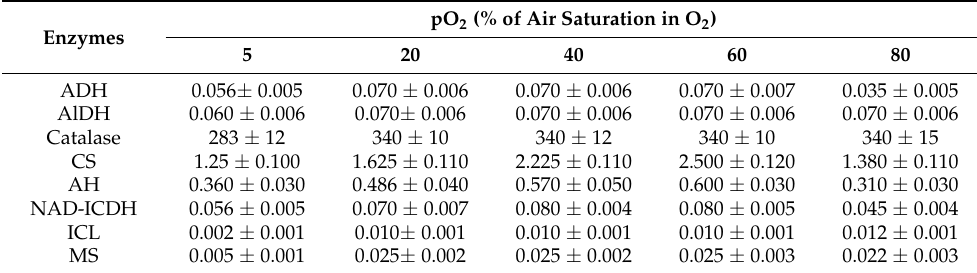
Table 6. Effect of aeration on the enzyme activities (U/mg protein) of Y. lipolytica VKM Y-2373.